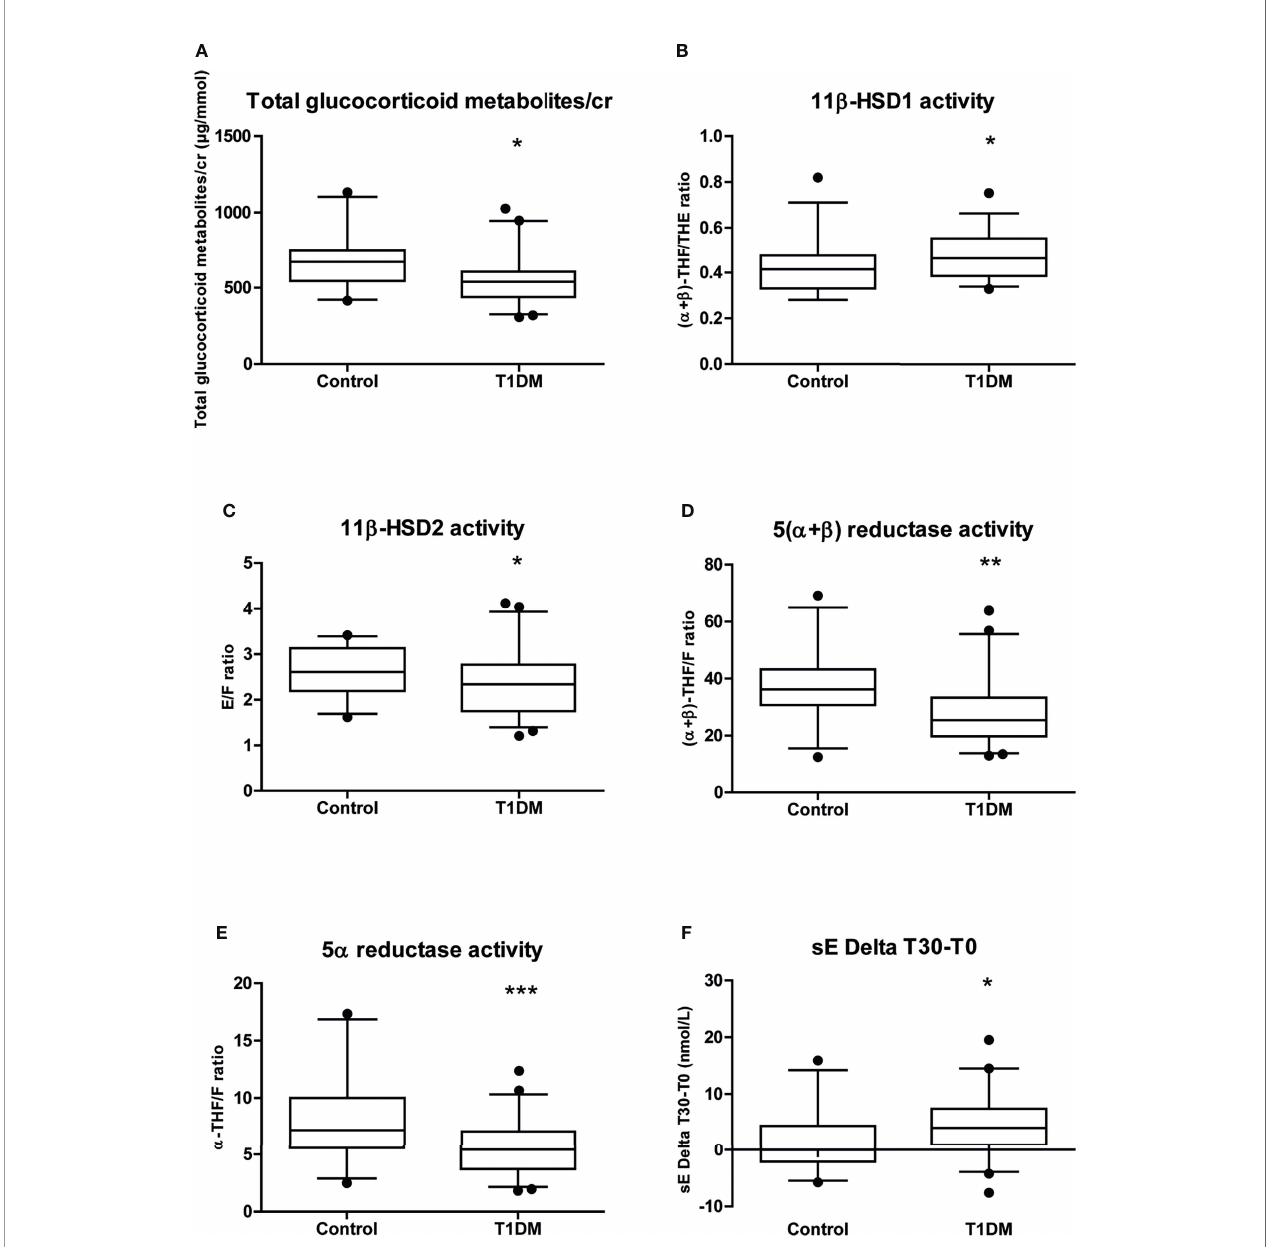
FIGURE 2 | Whisker plots representation of the main cortisol metabolism results from the data in Table 2 . Whisker plots of (A) glucocorticoid metabolites/cr; (B) 11 b -HSD1 activity; (C) 11 b -HSD2 activity; (D) 5( a + b ) reductase activity; (E) 5 a reductase activity; (F) sE Delta T30-T0. Data are expressed as median [25-75% percentile: plot; 5-95% percentile: whiskers]. Points below and above the whiskers are drawn as individual points. T1DM, type 1 diabetes mellitus; F, cortisol; E, cortisone; THF, tetrahydrocortisol; THE, tetrahydrocortisone; sF, salivary cortisol; sE, salivary cortisone;/cr, to creatinine. * p < 0.05; ** p < 0.01; *** p <